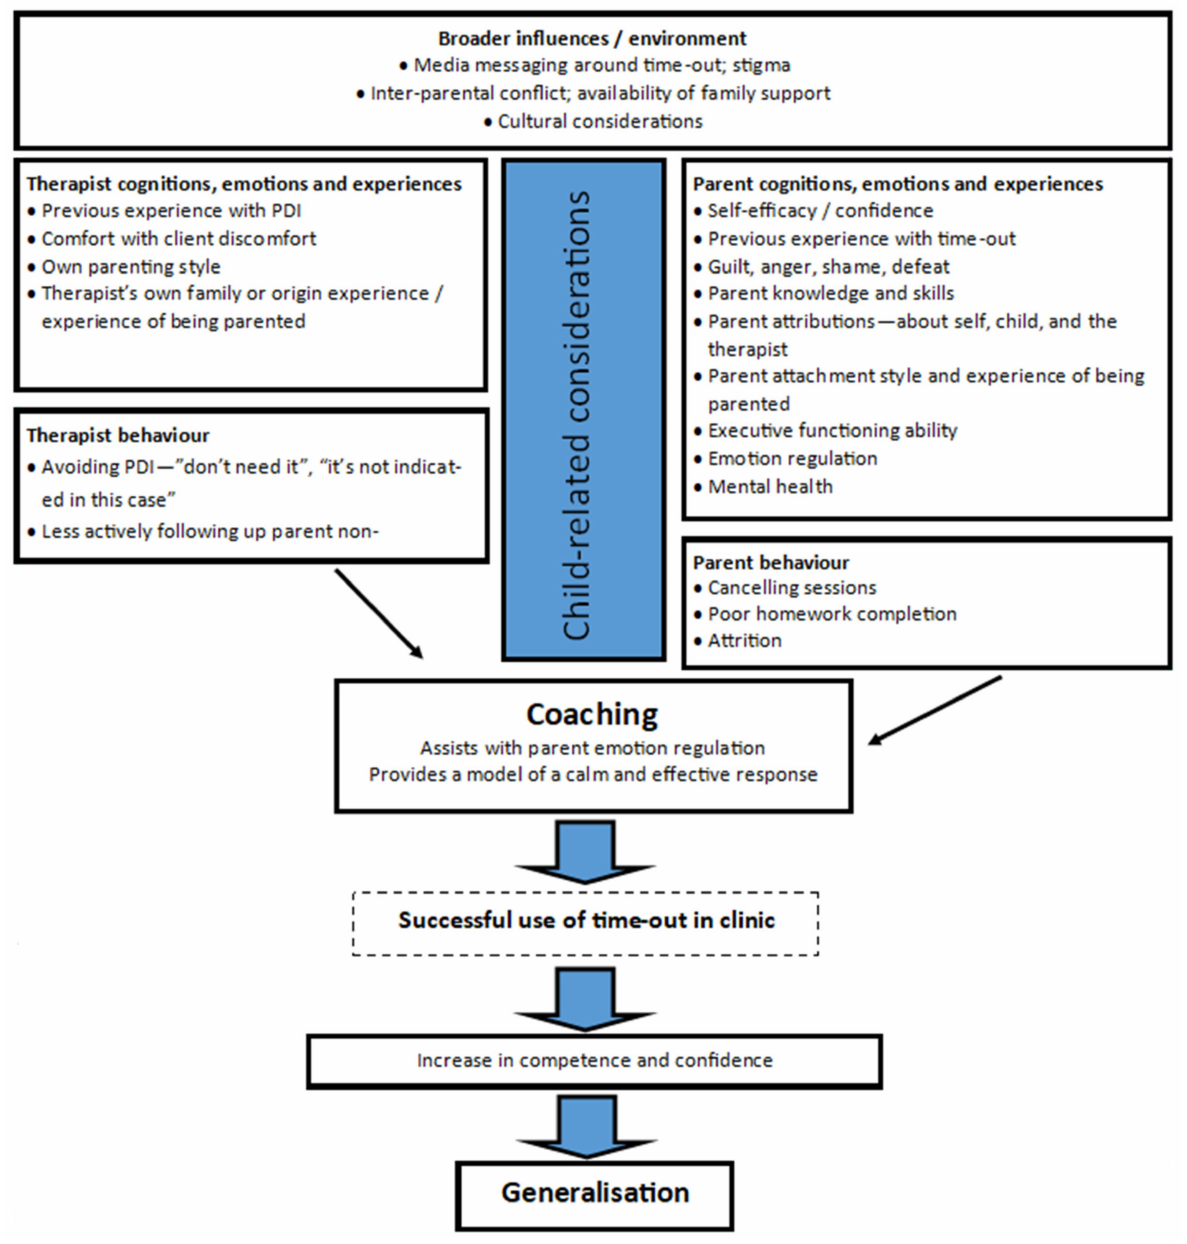
Figure 1. Summary of parent-practitioner related